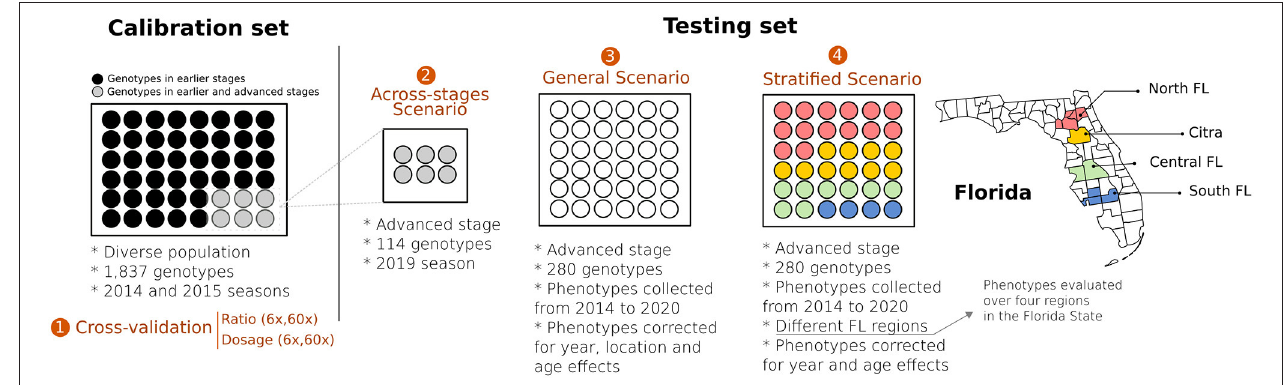
FIGURE 1 | Schematic representation of four validation scenarios tested in blueberries. Calibration set represents a diverse group of genotypes representative of the UF blueberry breeding population. In Scenario 1, we used the calibration set in a 10-fold cross-validation scheme to test the relevance of genotyping calling (ratio vs. dosage) considering two different sequencing depths (6 × and 60 × ). Scenario 2 (across-stages) represents a group of 114 individuals originally presented in the calibration set that were clonally propagated, moved to the advanced Stage of the breeding program, and phenotyped under commercial field conditions. Scenario 3 (general prediction) represents an independent group of 280 genotypes (testing set), evaluated under commercial conditions. The phenotypic values of the target individuals were pre-adjusted for the year, location, and age effects. Finally, in Scenario 4 (stratified prediction), we performed predictions over four regions of the State of Florida. To avoid potential model overfitting, we removed genotypes from the calibration set overlapped with the testing